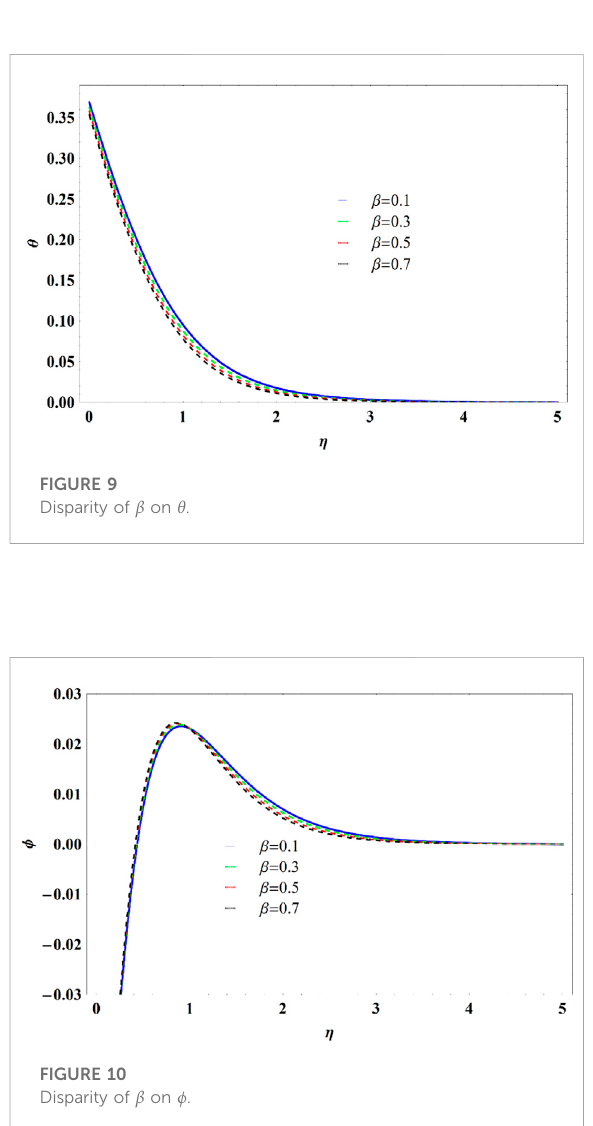
FIGURE 11 Disparity of δ on θ